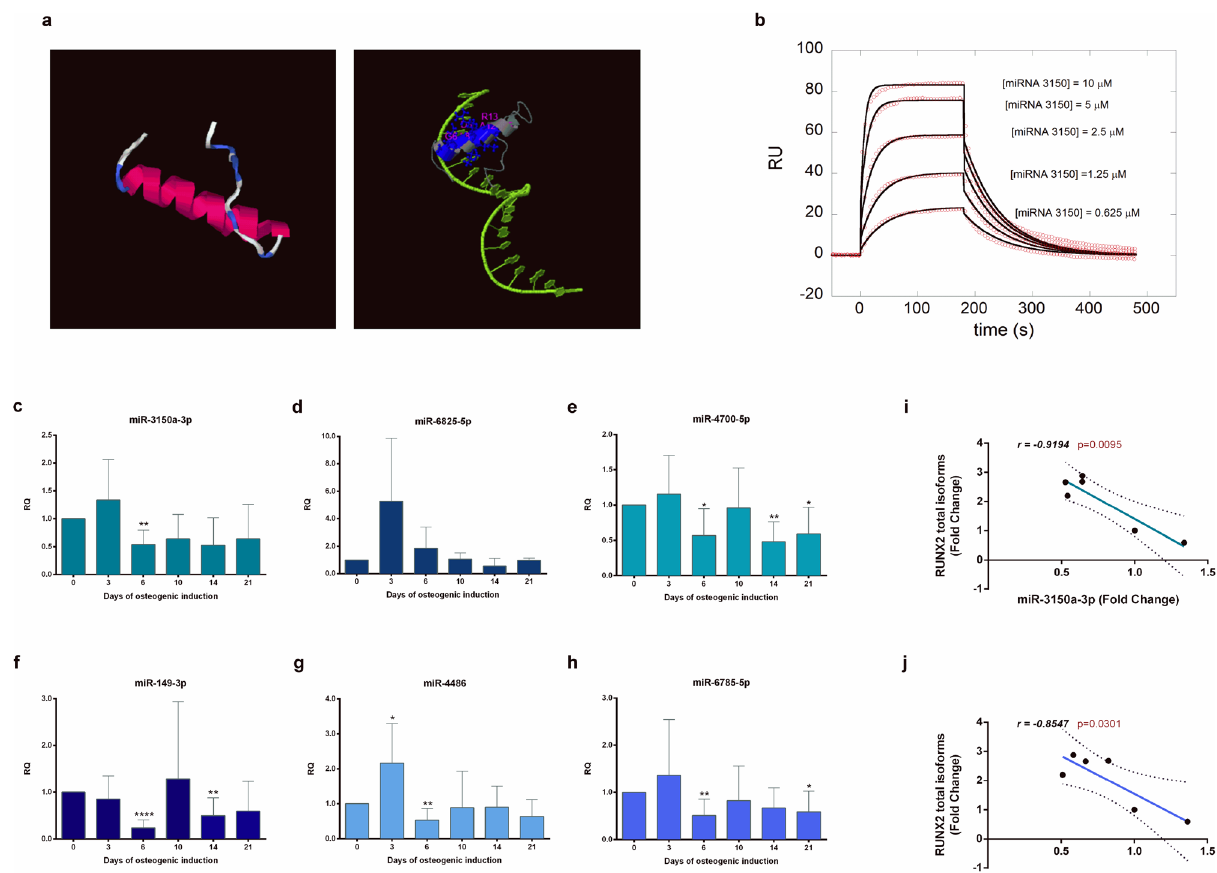
Figure 7. In silico modelling and miRNA profiling. (a) The images show the three-dimensional computational modelling of the last coding exon of the RUNX2 isoform containing the distal 3’UTR and its predicted interaction with DNA, by I-TASSER tool (https:// zhang lab. ccmb. med. umich. edu/I- TASSER/). (b) Surface plasmon resonance data showed the changes in miRNA-target binding affinities. Representative graph showing at different analytes’ concentration, while the black lines are the global fit using a 1:1 kinetic model. (c–h) The bar graphs show the changes in relative expression of miR-3150a-3p, miR-6825-5p, miR-4700-5p,